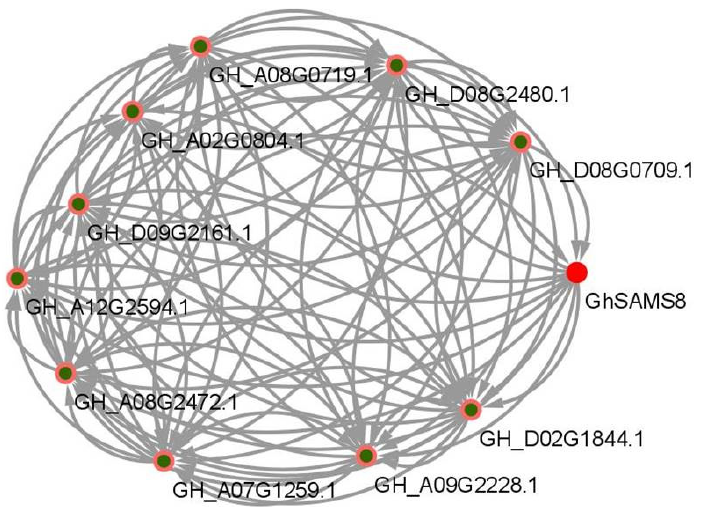
Figure 8. Interaction network of GhSAMS8 proteins in upland cotton.